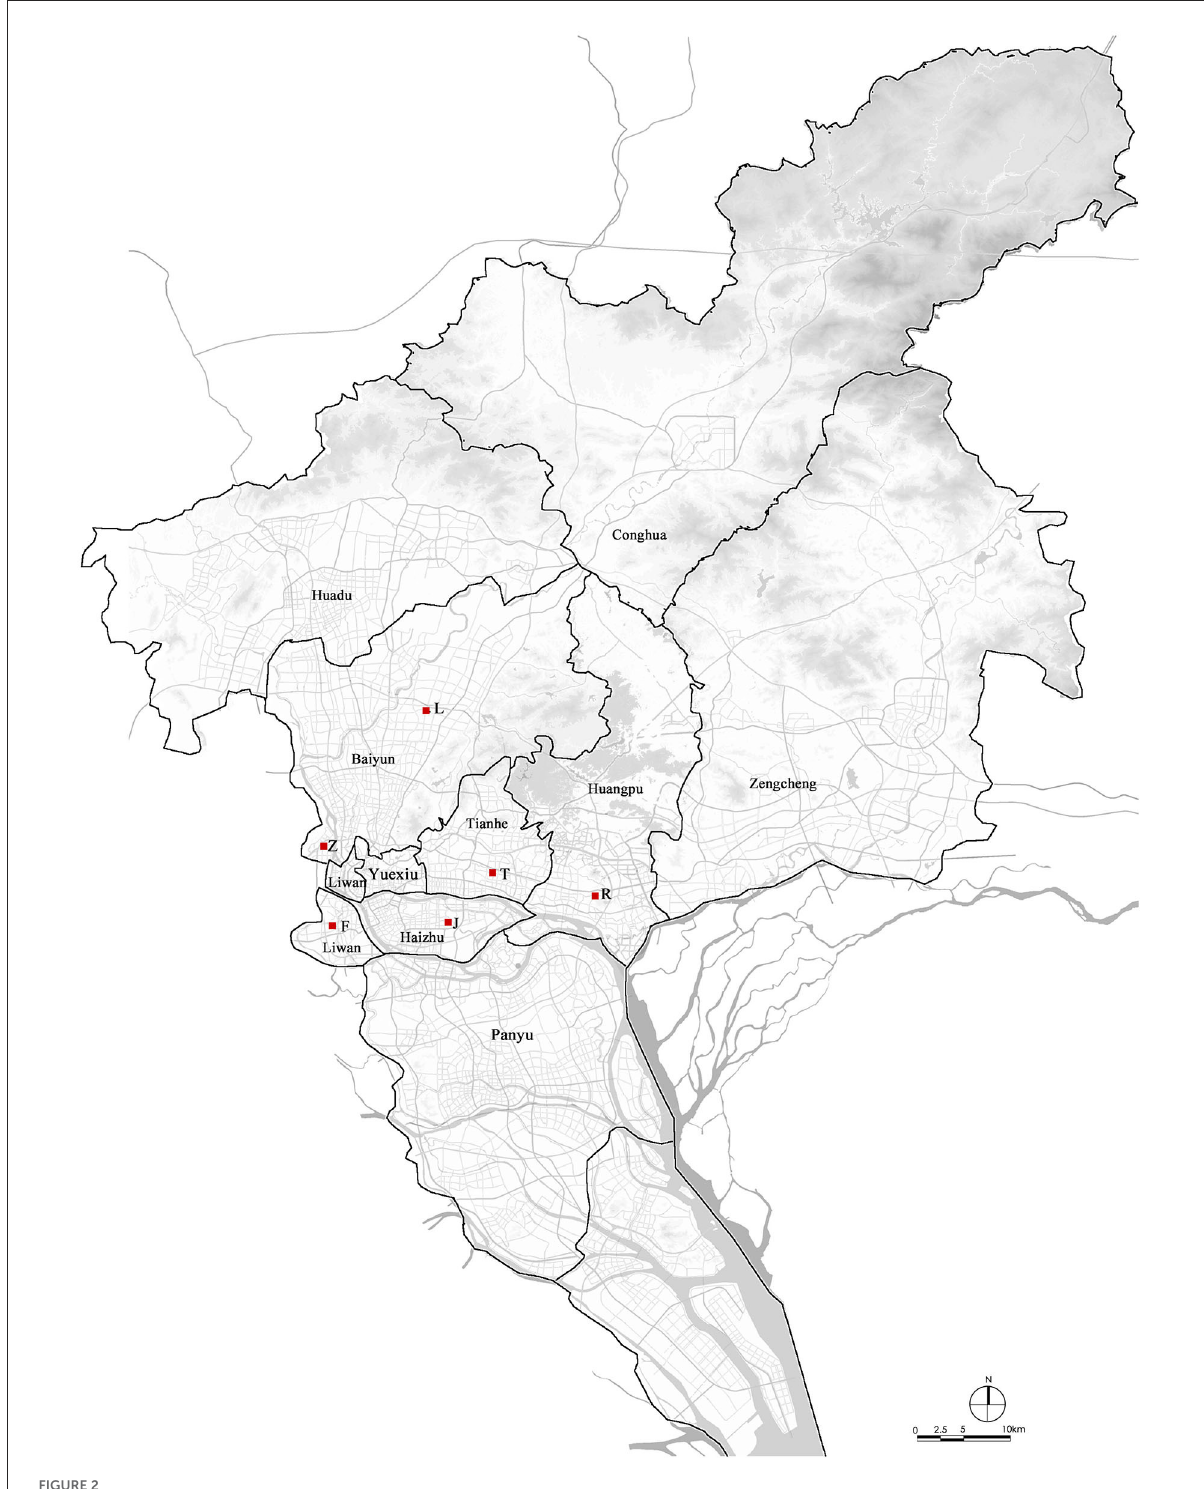
FIGURE2 The study